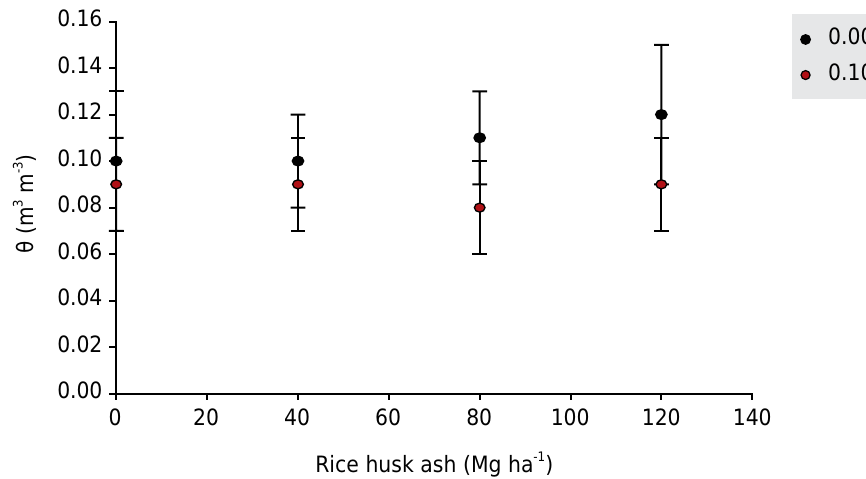
Figure 5. Available water capacity (AWC) of a Typic Hapludult under different rates of rice husk ash at the layers 0.00-0.10 and 0.10-0.20 m. Vertical bars indicate the standard